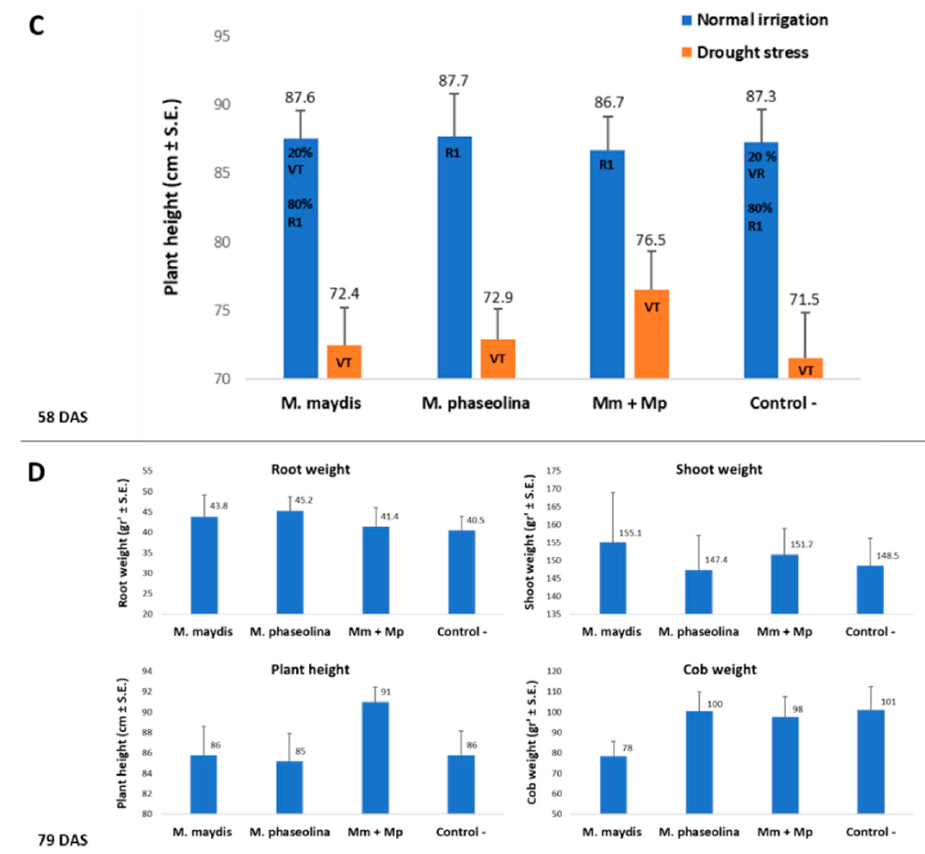
Figure 4. Symptoms evaluation and yield assessment in maize . Plant developmental values and yield assessment was made for the plants in the 2019 experiment described in Figure 2. Sprout emergence, 9 DAS ( A ), phenological stage, 23 DAS ( B ), plant height, 58 DAS ( C ), and growth and yield assessment 79 DAS and 22 DAF ( D ) were determined after the inoculation of the plants with M. maydis and M. phaseolina , alone or in mixed inoculation. Vertical upper bars represent the standard error of the mean of 10 replications (pots, each containing one plant from 23 DAS onwards). When existing, significance from the control (untreated) is indicated as * = p < 0.05.